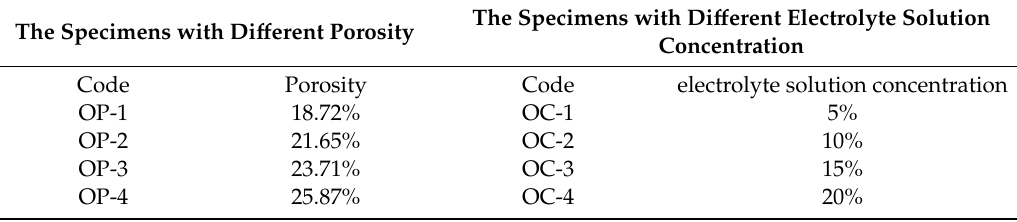
Table 4. The specimen codes for open-circuit potential